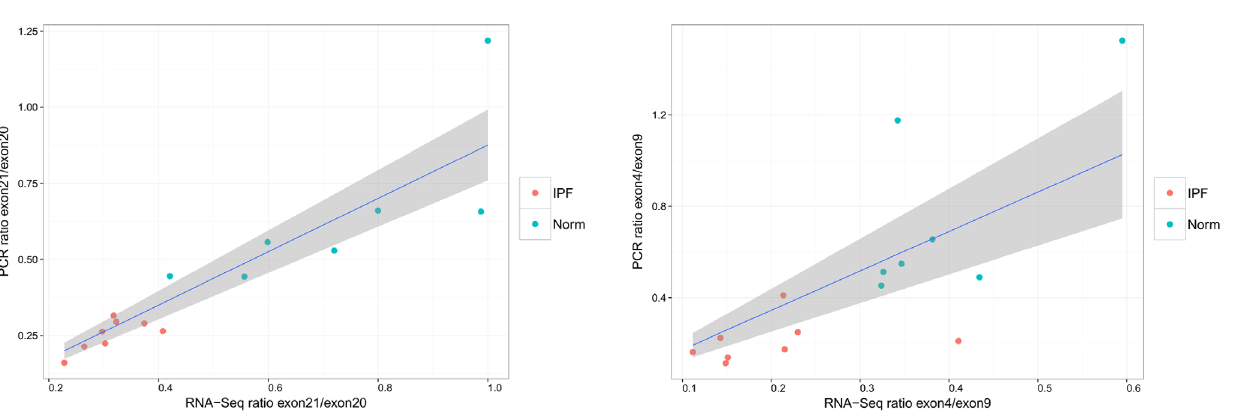
Figure 8. Ratios of COL6A3 exon usage calculated from qPCR vs. RNA-Seq. The grey area indicates 95% confidence interval for the linear regression.